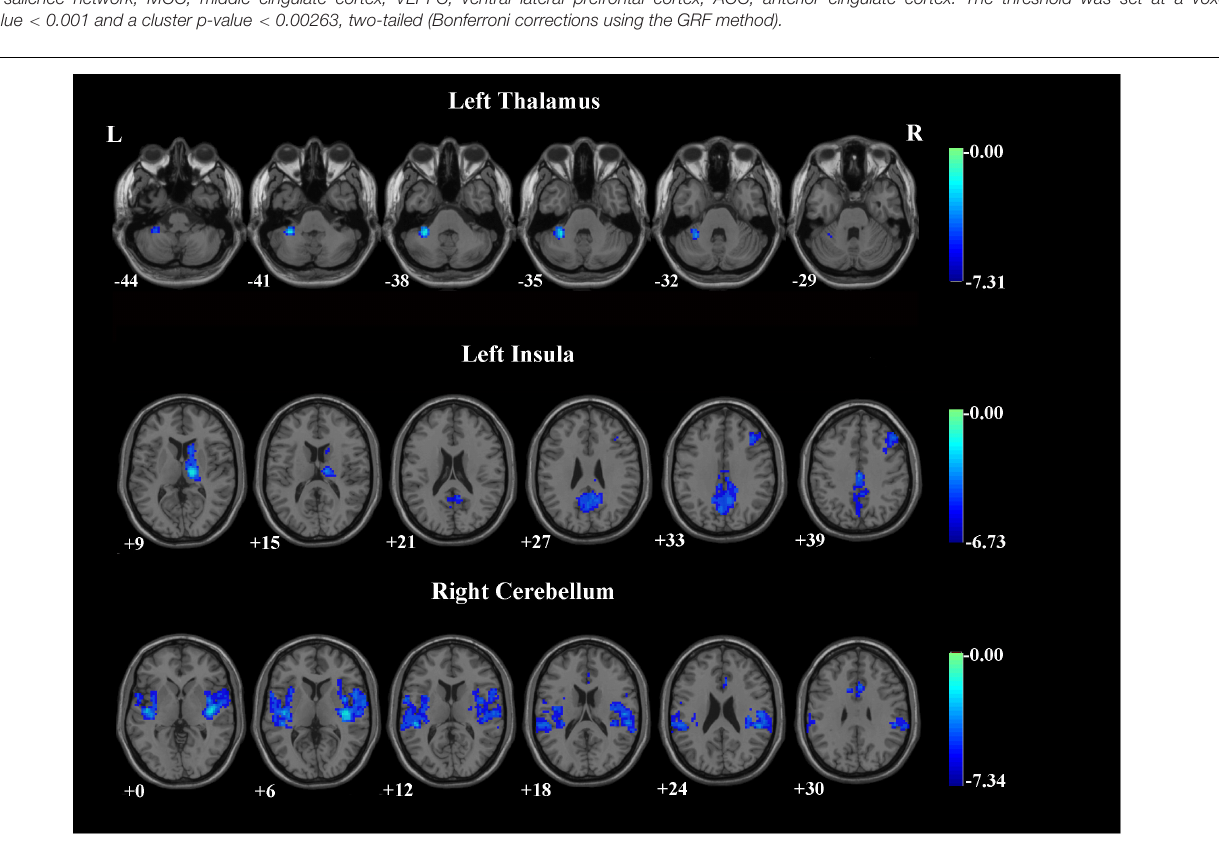
Frontiers in Neuroscience |